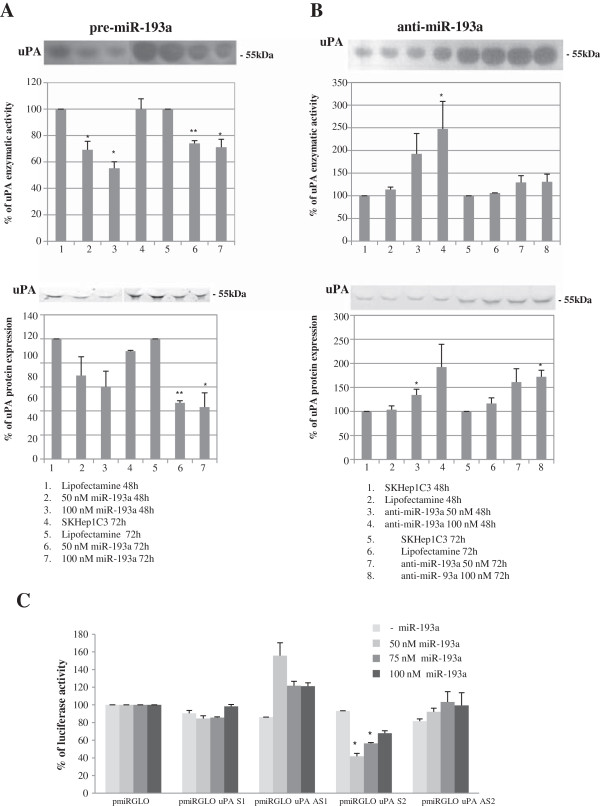
Experimental validation of miR-193a as negative regulator of uPA in SKHep1C3 cells. (A) pre-miR-193a transfections in SKHep1C3 cells inhibited uPA protein expression and the enzymatic activity. (B) Anti-miR-193a transfection in SKHep1C3 cells led to up-regulation of uPA protein expression and the enzymatic activity up-regulation, *p < 0.05; **p < 0.01 versus Lipofectamine in a t-Test analysis for unpaired comparison. (C) The dual luciferase assay shows that the site 2 was directly bound by miR-193a but the site 1 was not. pmiRGLO uPA S1 and pmiRGLO uPA S2 are the luciferase constructs expressing the predicted 3′ UTR mRNA uPA binding site 1 and site 2. The pmiRGLO uPA AS1 and pmiRGLO uPA AS2 are the constructs expressing the corresponding control antisense sequences, *p < 0.05 versus – miR-193a.